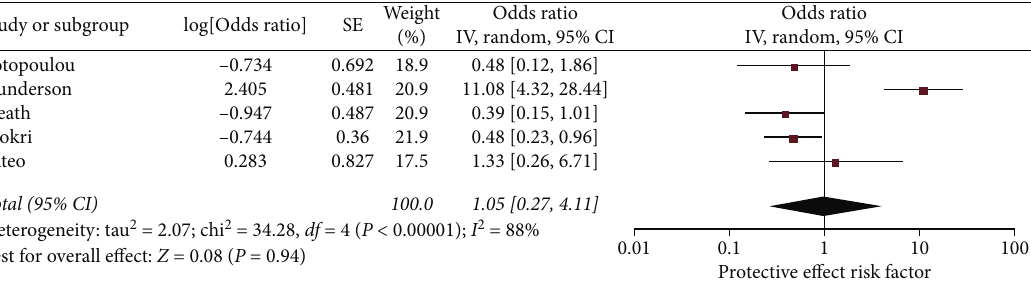
Figure 5: Forest plot of the odds of VTE in ovarian cancer patients that have complete cytoreduction surgery with no tumor mass left (versus incomplete cytoreduction with tumor mass left). This figure shows the pooled odd of complete cytoreduction (versus incomplete cytoreduction). The total pooled odds are 1.05